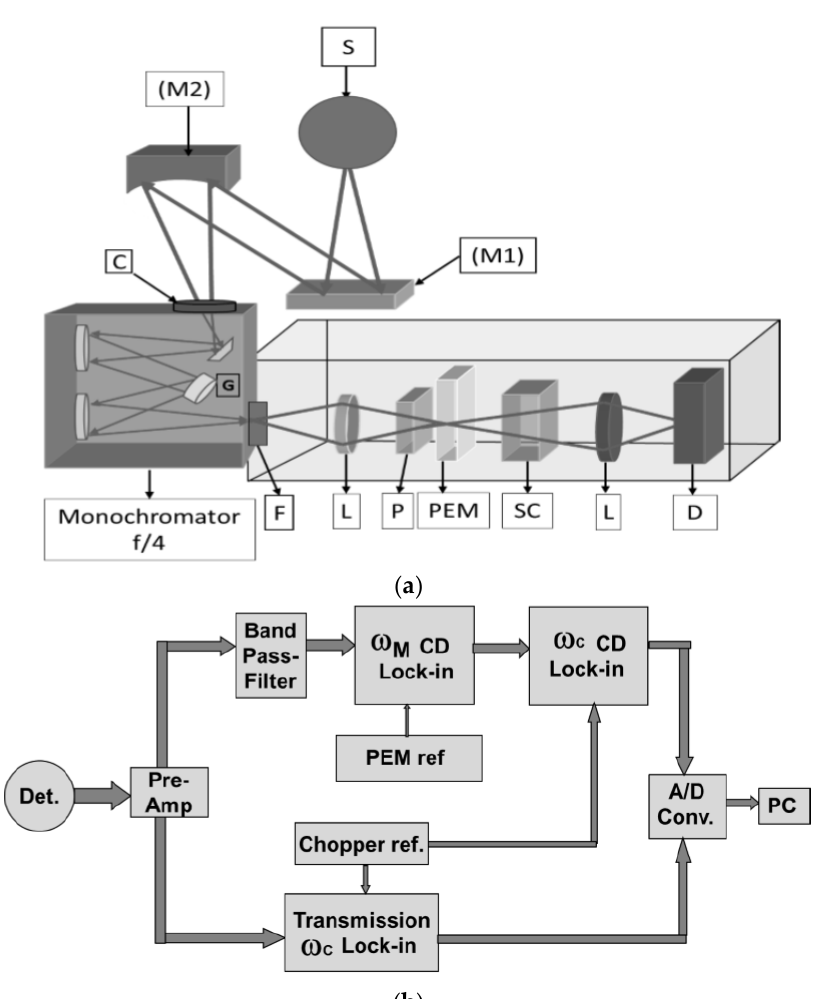
Figure 1. ( a ) Schematic diagram of the optical components of an improved dispersive vibrational circular dichroism (VCD) spectrometer, optimized for peptide and protein studies. S‐Carbon‐rod light source in cooled housing; M1: Flat mirror; M2: focusing mirror; C: rotating wheel chopper (150 Hz); G: exchangeable monochromator grating (on turret, 150 or 200 mm/groove); F: optical long wave pass filter; P: wire gird polarizer (BaF 2 ); PEM: photoelastic modulator (ZnSe); SC: sample cell; L: lens; D: MCT detector. ( b ) Schematic diagram of the electronics components of the new dispersive VCD spectrometer. Each component is designated in the diagram.